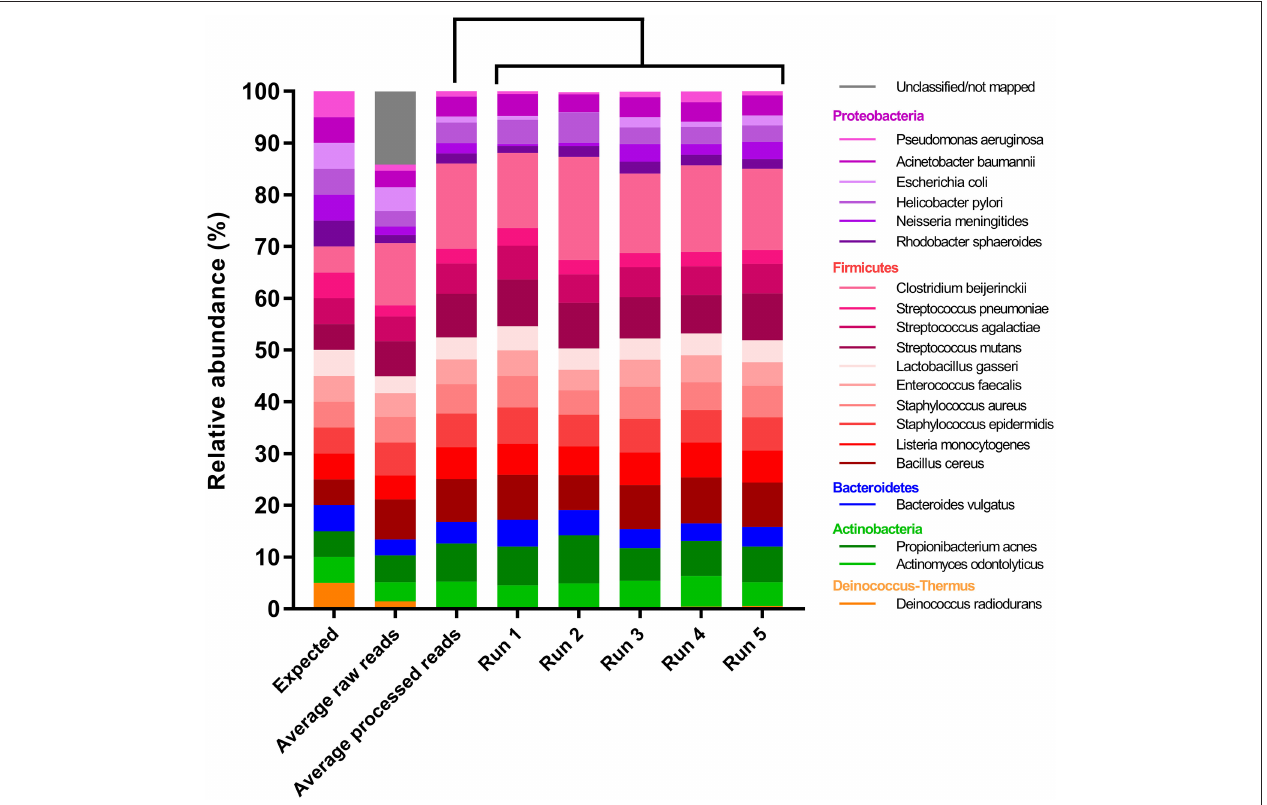
FIGURE 1 | Relative abundance estimates of the 20-member mock community compared with the expected. Columns from left to right: Expected relative abundances, average relative abundances using the raw reads, average relative abundances using the processed reads and relative abundances in each of the five sequencing